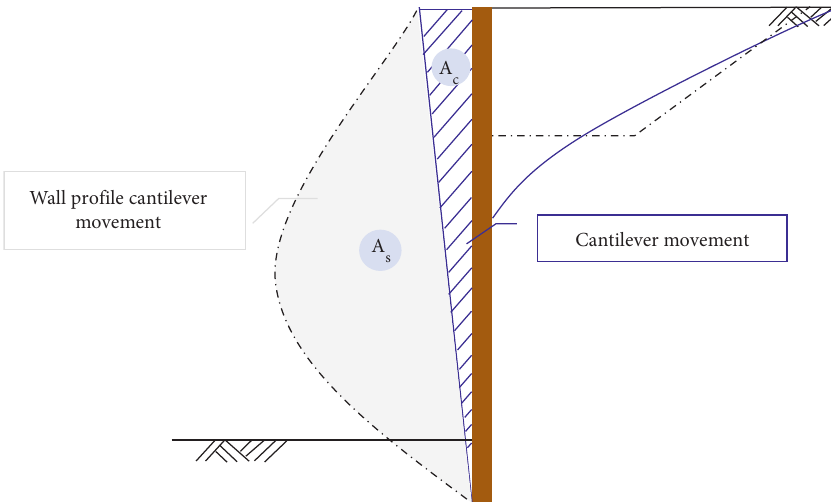
Figure 19: Diagram of cantilever movement and wall profile cantilever